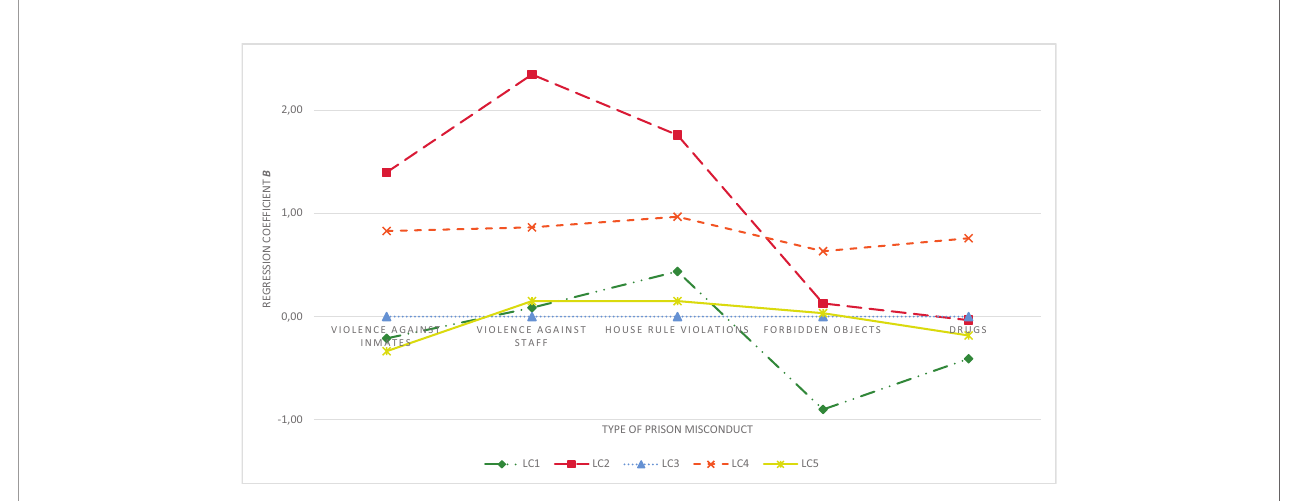
FIGURE 2 | Regression coef fi cients ( B ) for several types of prison misconduct by Latent Class. LC3 ( n = 109) served as reference group.